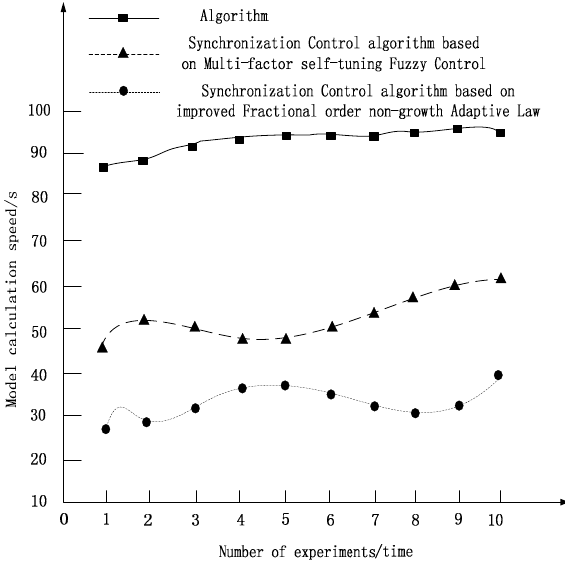
Figure 6. Computational Speed Contrast Diagram of Fuzzy Neural Network Models with Three